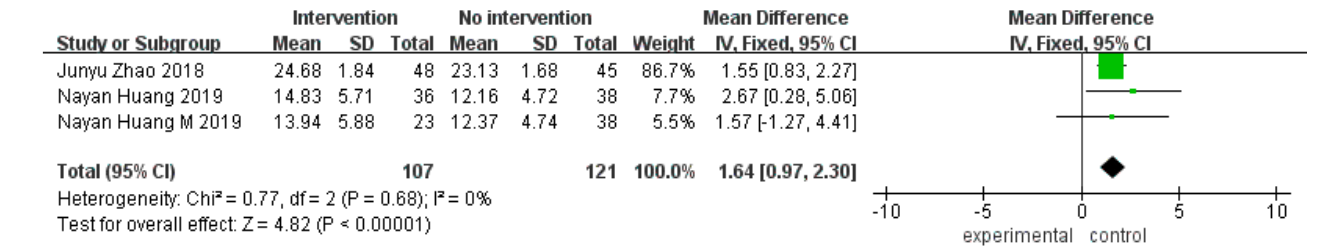
Figure 4. Forest plot of MoCA scale for overall cognitive function improvement [32,33].